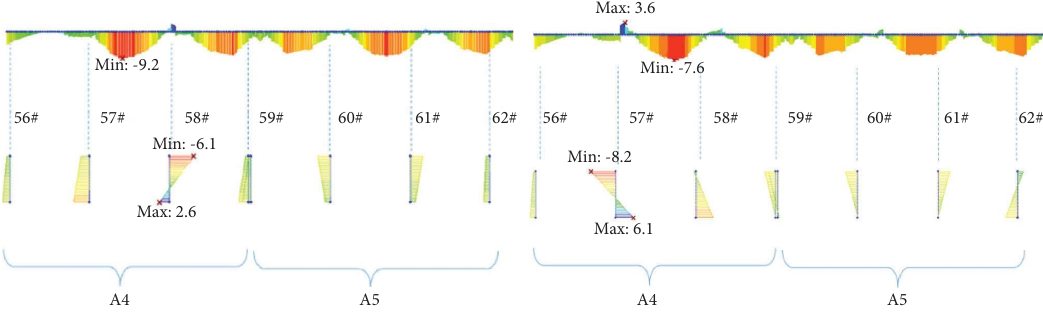
Figure 13: Stress diagram of the girder and pier under temperature rise and drop